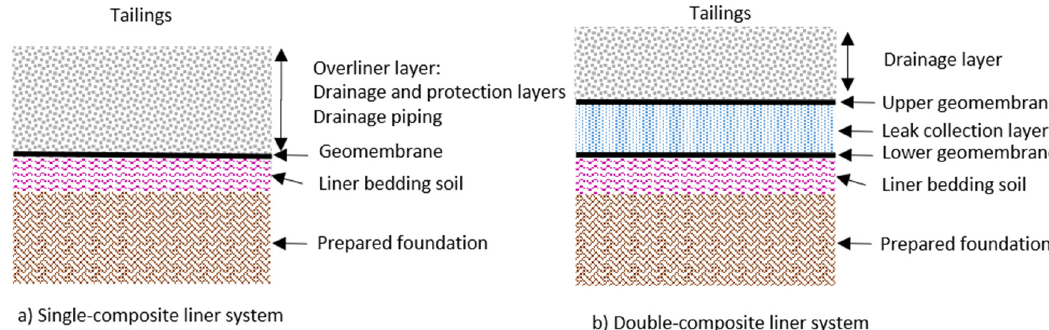
Figure 7. ( a ) A typical single-composite liner system used in tailings storage facilities (TSF) according to Lupo, modified from [60], and ( b ) an advanced solution rarely used in TSF, but more common in heap leaching, modified from [43].